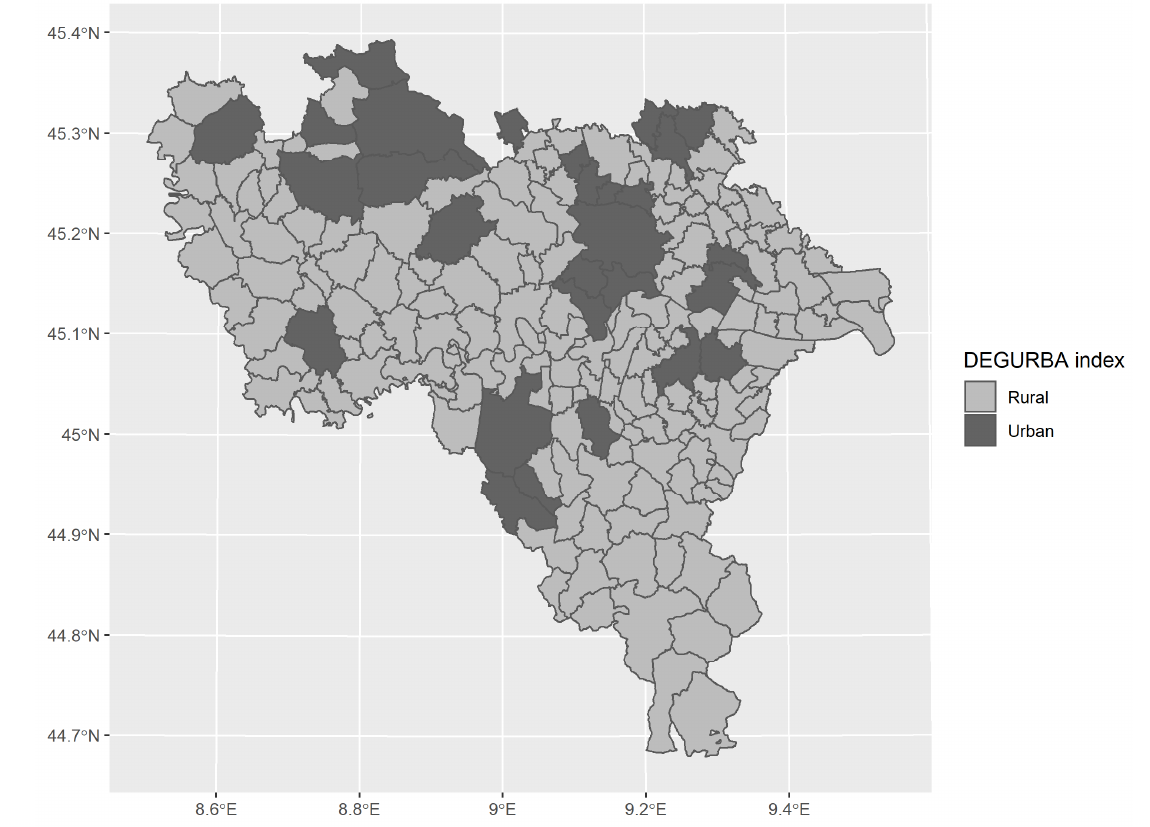
Figure 3. Spatial distribution of the DEGURBA index (degree of urbanisation index): the degree of urbanisation was considered invariant throughout the study period. Table 2. Summaries of observed cardiovascular deaths and crude mortality rate in each year of the study period by